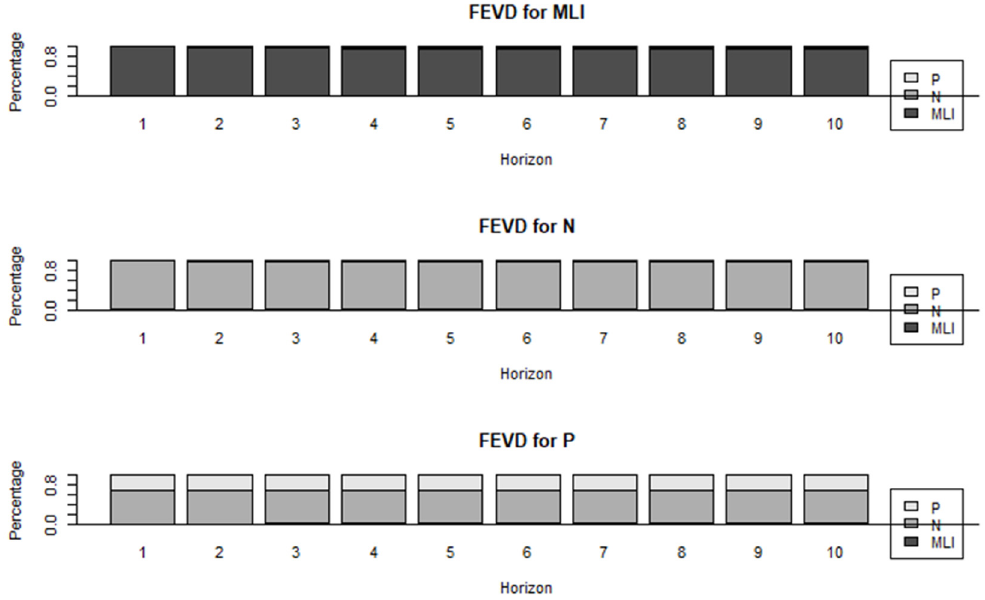
Figure 4. FEVD analysis for MLI and investor sentiments.